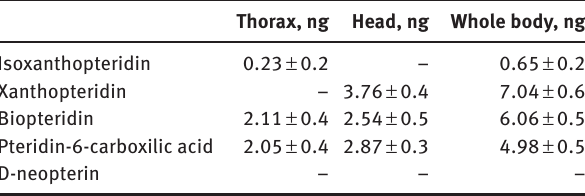
Table 1: Concentration of different pteridines molecules detected in thorax, head and whole body of Anopheles stephensi (n =